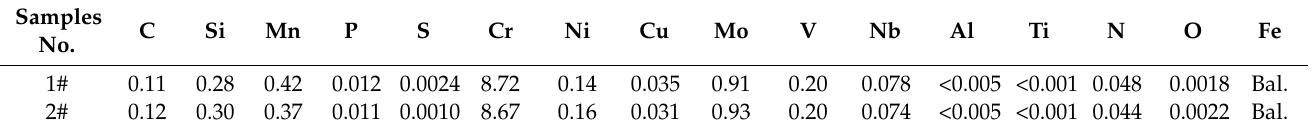
Table 1. Main elemental composition of P91 steel pipe samples